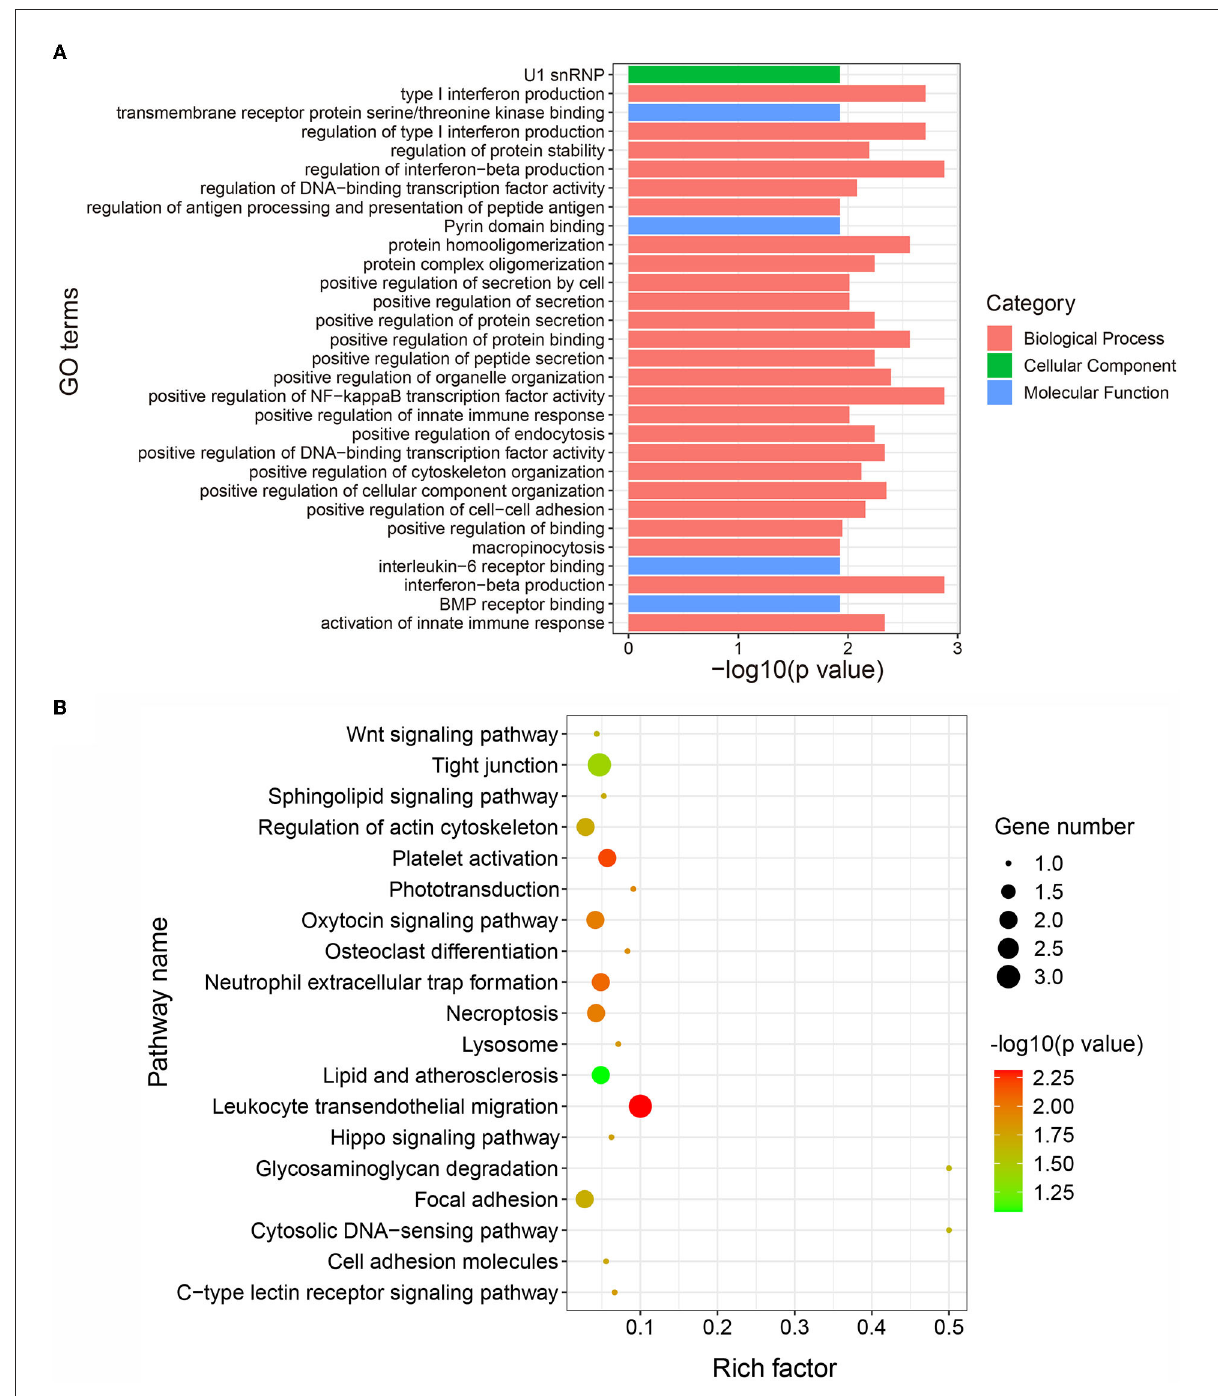
FIGURE4 Gene ontology (GO) and Kyoto Encyclopedia of Genes and Genomes (KEGG) functional enrichment analysis of differentially abundant proteins (DAPs). (A) Top 30 significantly enriched GO terms. The X-axis represents the –log10 ( p value) value of the GO terms and the Y-axis represents the GO term name. (B) Significantly enriched pathways of DAPs. The X-axis represents the rich factor and the Y-axis represents the pathway. The size and color of the bubbles represent the number of proteins enriched in the pathway and enrichment significance,